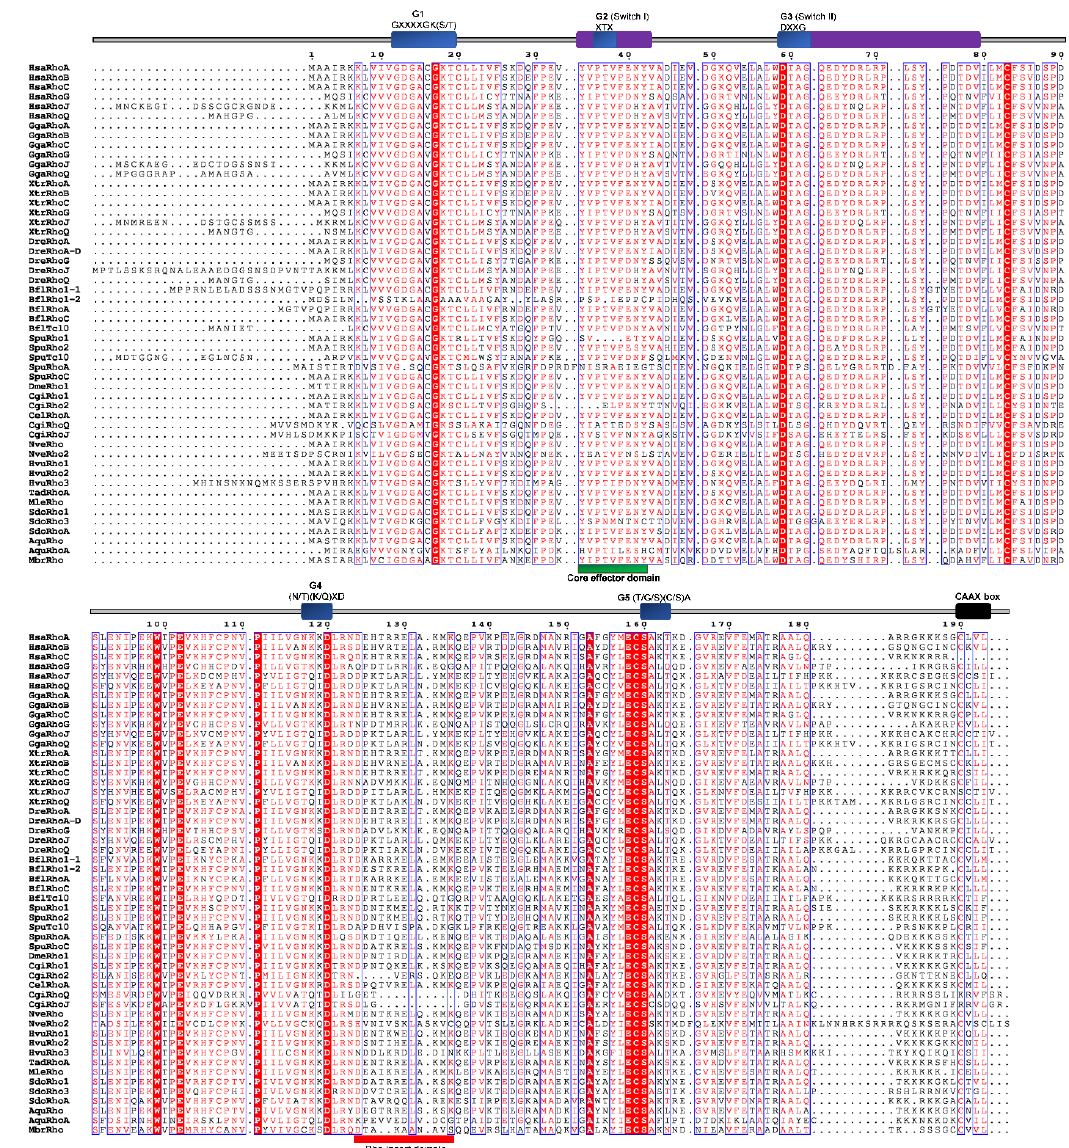
Figure 5. Sequence alignment of the Rho subfamily. The amino acid sequences of Rho GTPases were aligned using ClustalX, the secondary structures predicted using ESPript. Regions of the Rho proteins are indicated above the alignment; blue are the G domains, (G1, G2, G3, G4, and G5 with their respected motifs), purple are switch 1 and switch 2 domains, red is the Rho insert, green is the polybasic region, and black is the CAAX box. Blue frames are indicators of the conserved residues; white letters in red boxes represent strict identity, red letters in white boxes represent similarity.